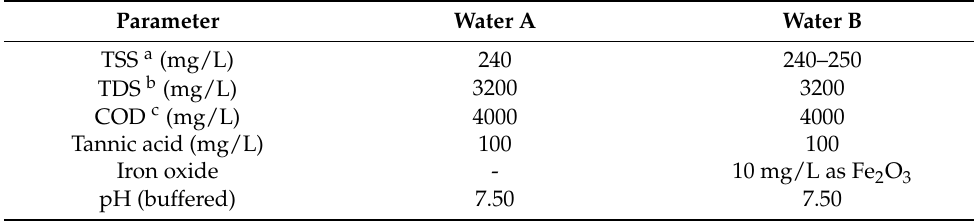
Table 1. Characteristics of the synthetic cashew nut processed waters.